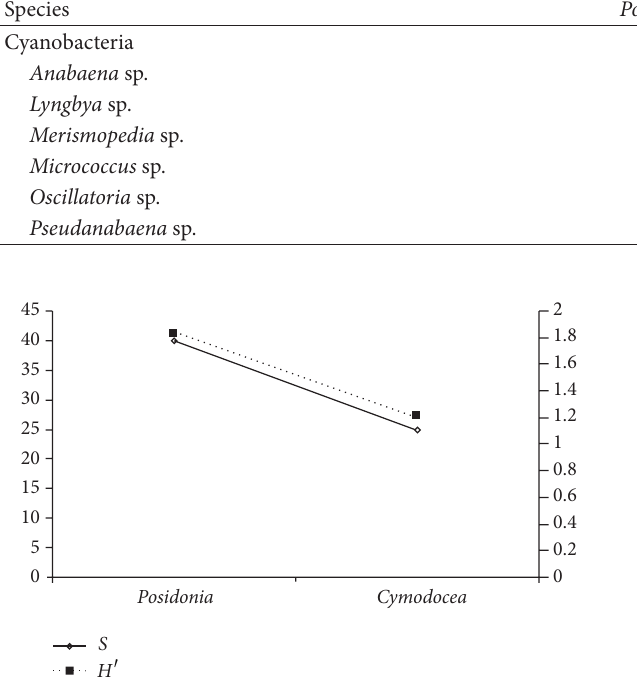
Figure 3: Mean diversity index ( 𝐻 󸀠 ) and species number ( 𝑆 ) on leaves in prospected stations.